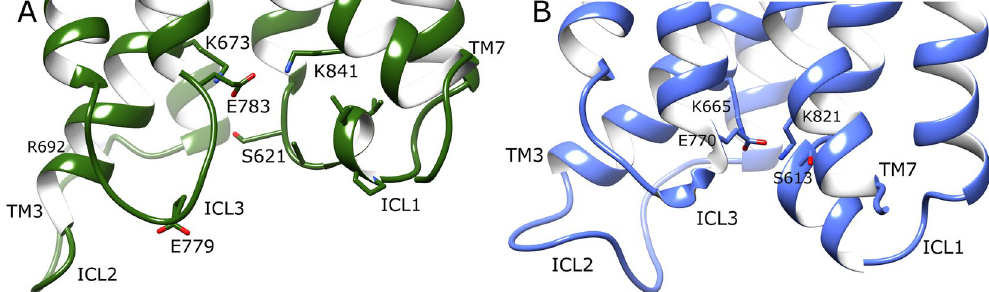
Figure 10. Average conformations of intracellular loops and selected charged/polar residues of ( A ) MPEP- bound mGlu4 (green) and ( B ) MPEP-bound mGlu5 (blue), obtained from 2.5–5 µ s of respective MD simulations. Relevant structural features and residues are labelled, i.e. intracellular loops (ICLs), and ionic- locks: K673-E783 in mGlu4 and K665-E770 in mGlu5.